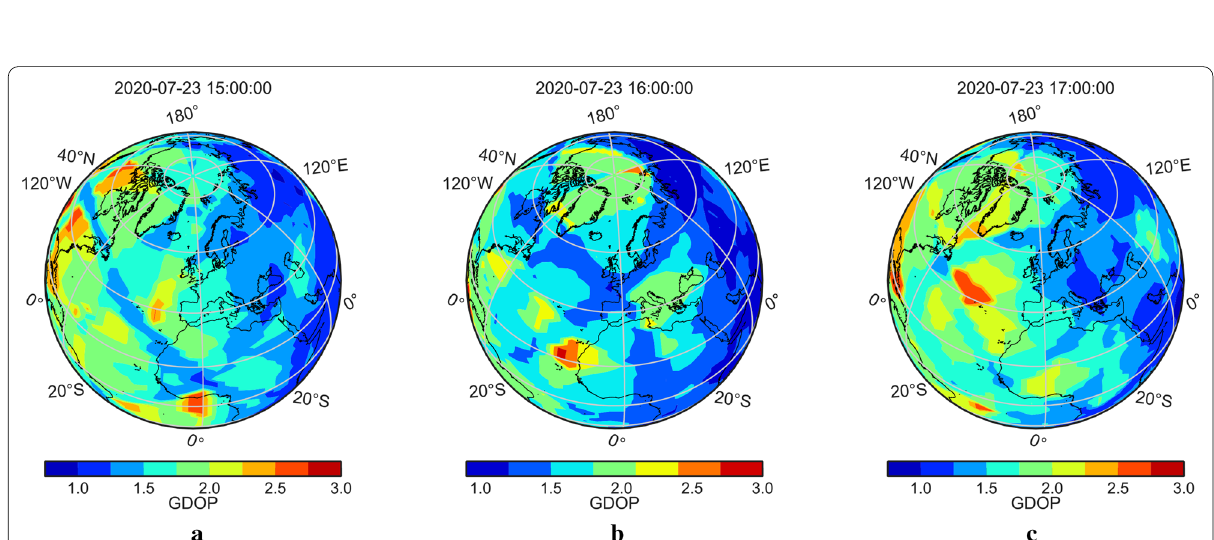
Fig. 4 GDOP distribution of BDS satellites with elevation angles above 5° at a GPS time 15:00:00, b 16:00:00, and c 17:00:00 on July 23,